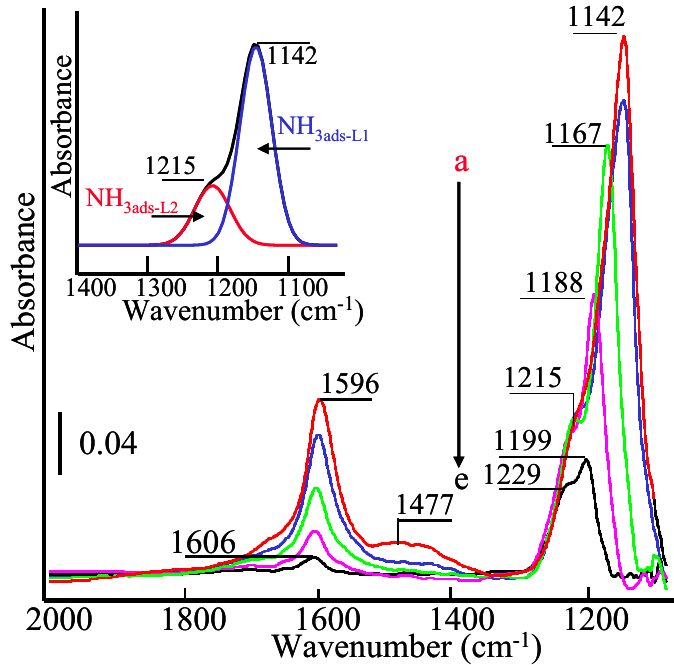
Figure 3. Impact of the adsorption temperature T a on the IR bands of the adsorbed NH 3 species on TiO 2 -P25 using 0.1% NH 3 /He: (a–e) T a = 300, 373, 473, 573 and 673 K. Inset: Decomposition of the δ s IR bands of the NH 3ads-L2 and NH 3ads-L1 species at 300 K.